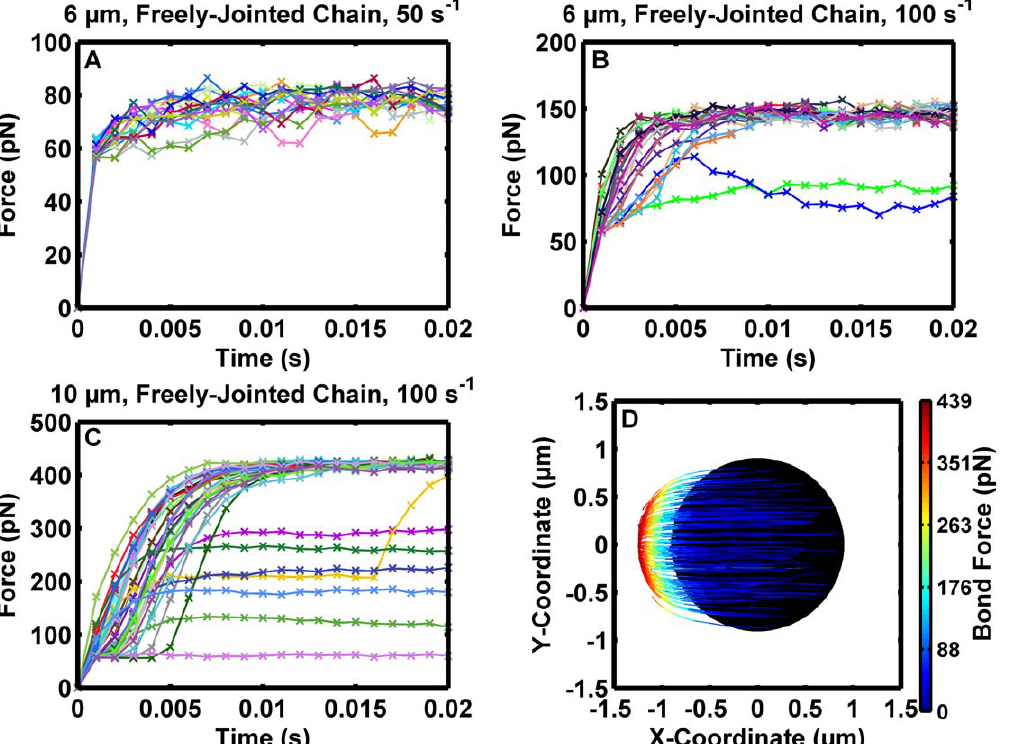
Figure 5. Loading patterns demonstrate how bond forces influence sphere motion. Reactive spheres were simulated with n L u =100 sites/ m m 2 , n R u =50 sites/ m m 2 , association kinetics governed by (1), and dissociation kinetics governed by (3). Note that the step function in the freely-jointed chain model, (6), resulted in a step from zero force to 56 pN as the tether extended past 92 nm, and then force continued to increase continuously. (A) A sample of bond loading data for 6 m m-diameter spheres with a 50 s 2 1 wall shear rate. (B) Results from a simulation for 6 m m-diameter spheres with a 100 s 2 1 wall shear rate. Note that bonds were aligned to their respective initial loading points in the figure, so the total instantaneous force exerted by the concurrent bonds, shown by the green and blue tracings, on the sphere cannot be calculated by summing the two values at the same time point on the plot. (C) Bond loading results from a 10 m m-diameter sphere at a 100 s 2 1 wall shear rate. Of the three cases, the larger sphere had the most bond loading events and also was the most likely to form simultaneous hydrodynamic force bearing bonds. (D) Loading trajectories for single, force-bearing bonds. Data were compiled from simulation runs for 10 m m-diameter spheres with a 100 s 2 1 wall shear rate. Individual tracings represent individual bond events, with position coordinates representing the position of the bond tether point on the sphere relative to the center, projected onto the XY plane. The color depicts the force on the bond. The black circle illustrates the expected contact patch for unstressed bonds when the sphere touches the wall to within the limits of the assumed roughness. Single bonds only supported minimal force initially, evident in the first 5 ms of loading in (C), but could only cause the sphere to wobble once the tether point exited the contact patch, apparent in (D).